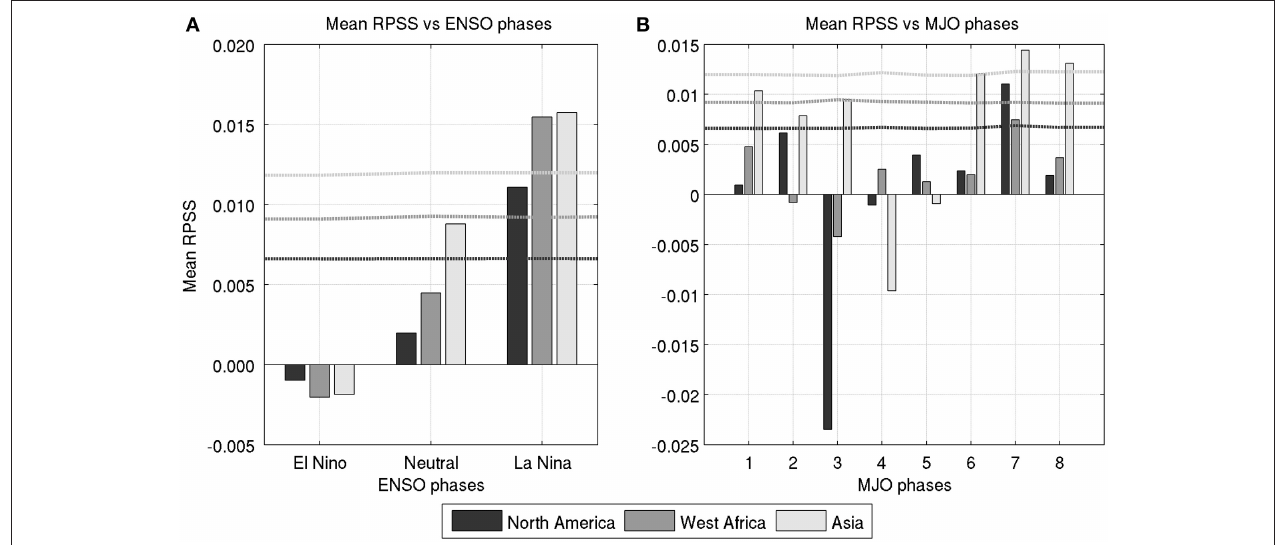
FIGURE 12 | Mean MME Week 3–4 RPSS averaged over continental monsoon regions for observed phases of Niño3.4 index (A) and MJO phases (B) measured by the RMM1 and RMM2 indices of Wheeler and Hendon (2004). Black, gray, and light gray lines correspond to the 90% level of significance over the respective North American, West African and Asian summer monsoon regions using Monte Carlo